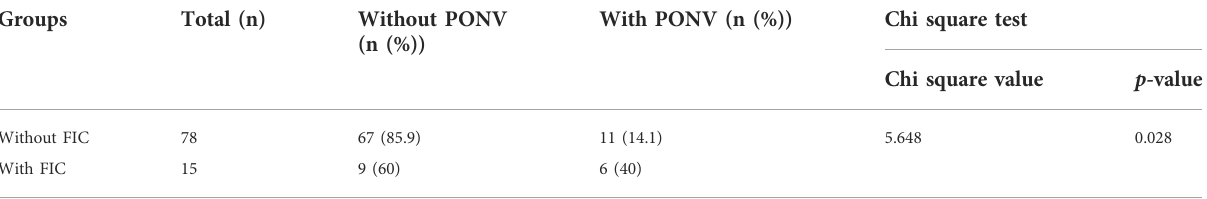
TABLE 8 The prevention of PONV and SIC by naloxone simultaneously (n (%)). Groups Total (n) Without PONV (n